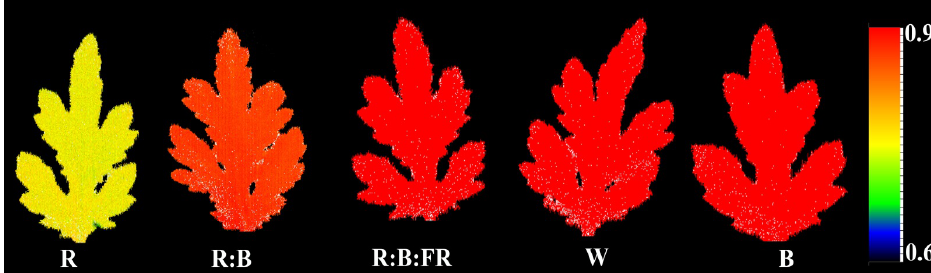
Figure 4. Pseudo-color images of maximum quantum yield of photosystem II (F v /F m ; (equations and explanations in Table 2)) exhibited by leaves sampled from chrysanthemum cuttings exposed for 30 days to different light quality regimes (red (R), red and blue (R:B), red, blue and far-red (R:B:FR), white (W) and blue (B); see the spectrum in (Figure 9). During the experiment, the photo-